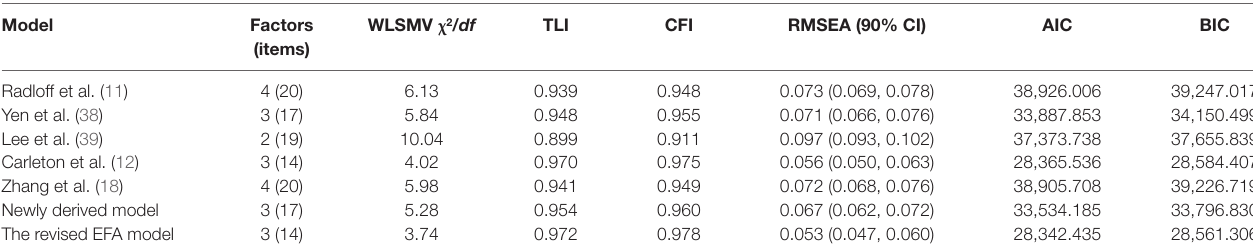
TABLE 2 | CFA fit indices and model comparisons for CES-D.